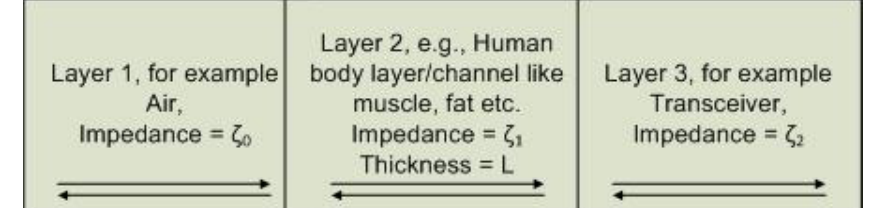
Figure 7. A propagation system consisting of 3 layers; air, human body channel, and a